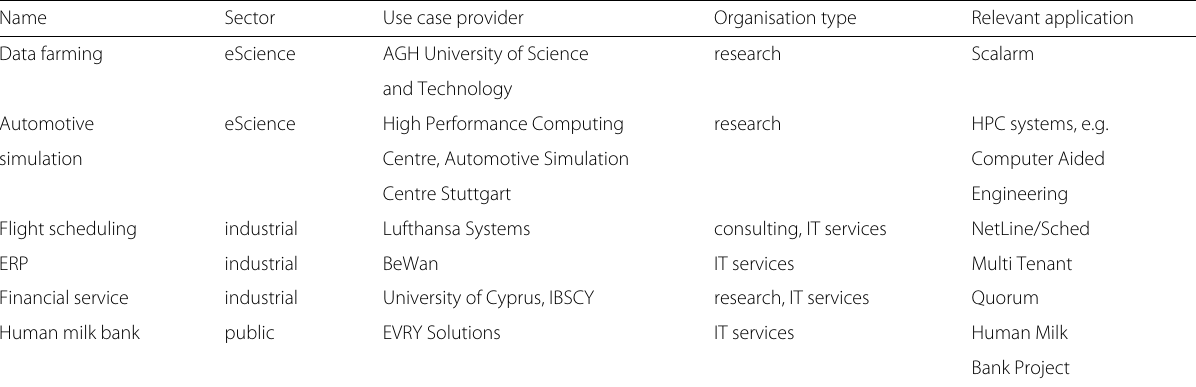
Table 3 The PaaSage use